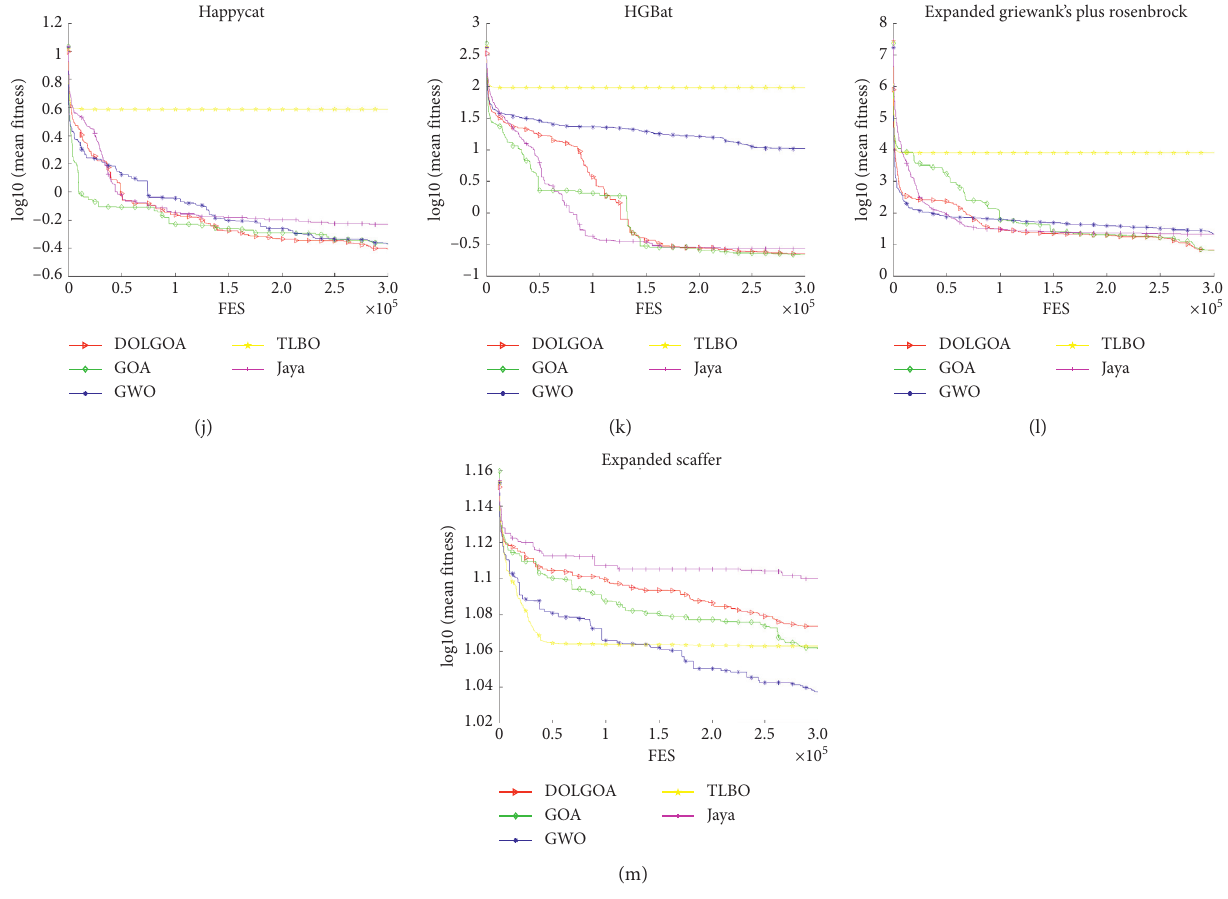
Figure 3: The convergence trends of all algorithms on multimodal functions.